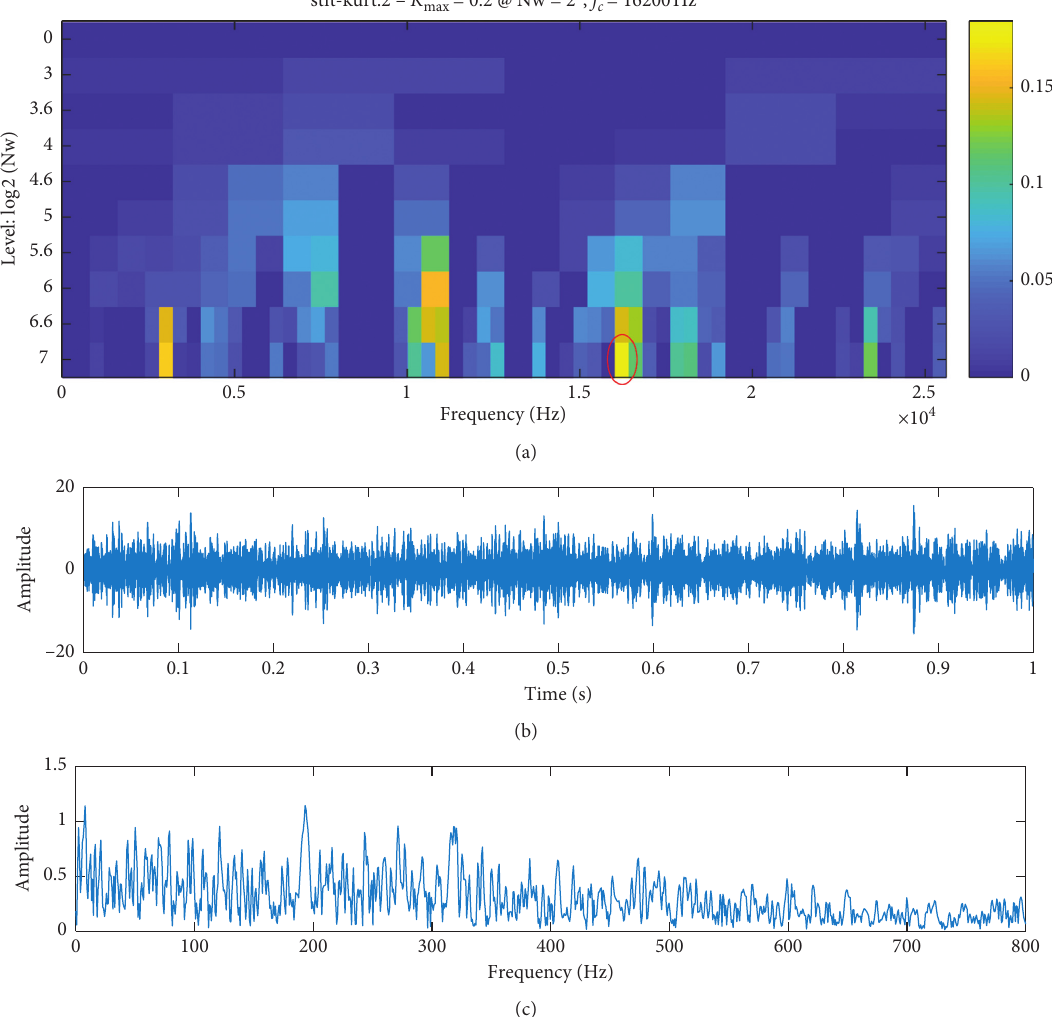
Figure 18: Experimental data in Figure 14(a) processed by the SK: (a) the paving of kurtosis values and (b) the signal filtered by frequency band (expressed by a solid red circle); (c) envelope spectrum of the filtered signal.